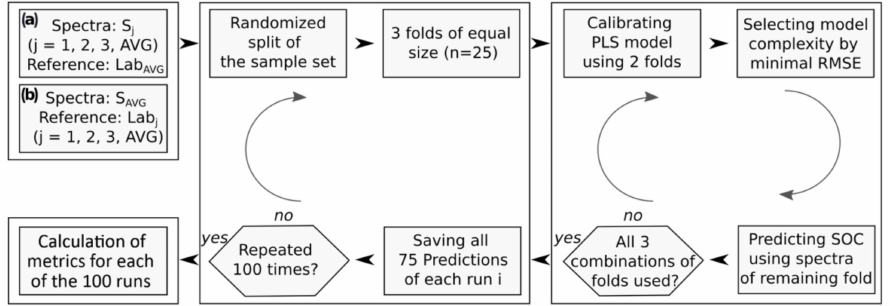
Figure 2. Processing scheme of the repeated cross-validation (CV) approach to study uncertainties from ( a ) spectral measurements and ( b ) reference SOC data.